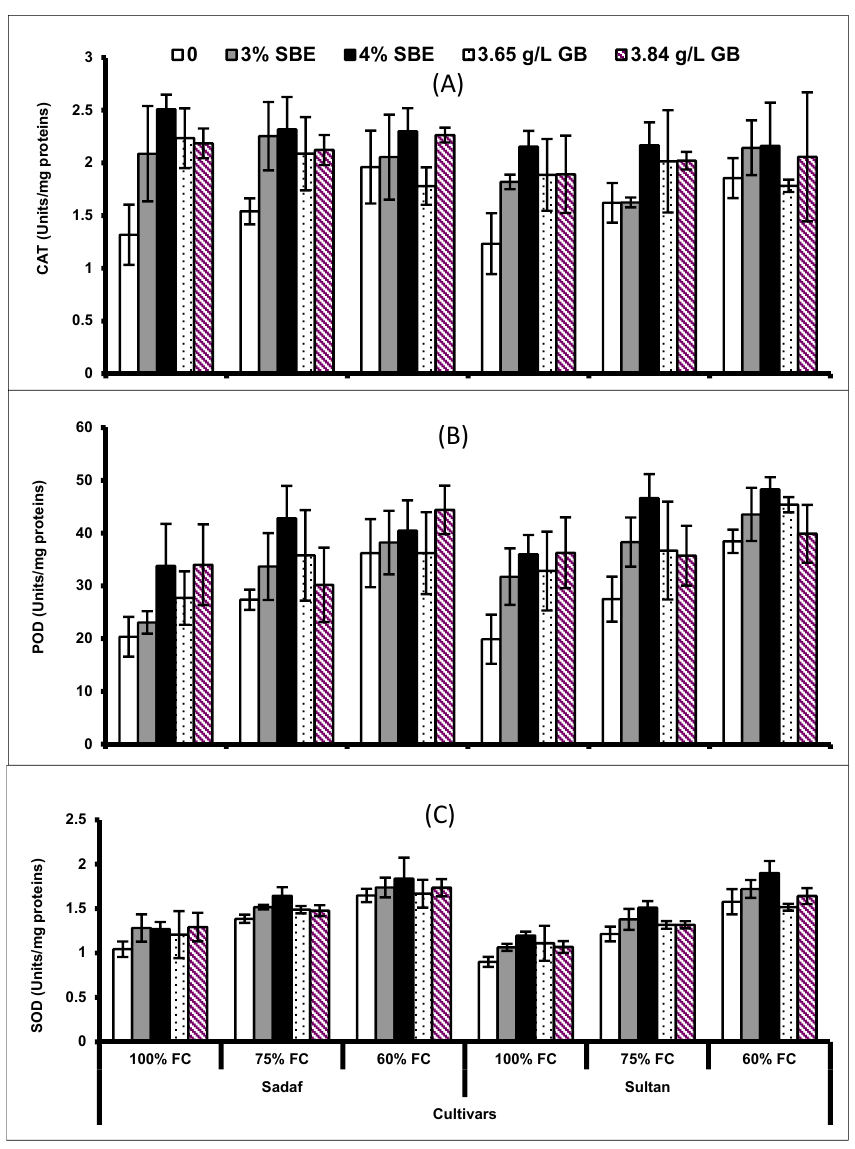
Figure 6. ( A ) Catalase (CAT), ( B ) peroxidase (POD) and ( C ) superoxide dismutase (SOD) of two maize cultivars foliar-fed with varying levels of sugar beet extract (SBE) and glycine betaine under water deficit conditions (Mean ± S.E.).